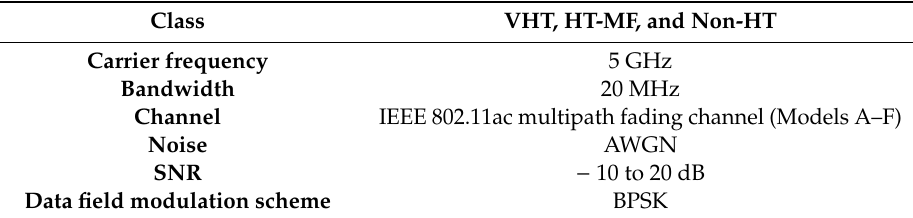
Table 2. Rx-data